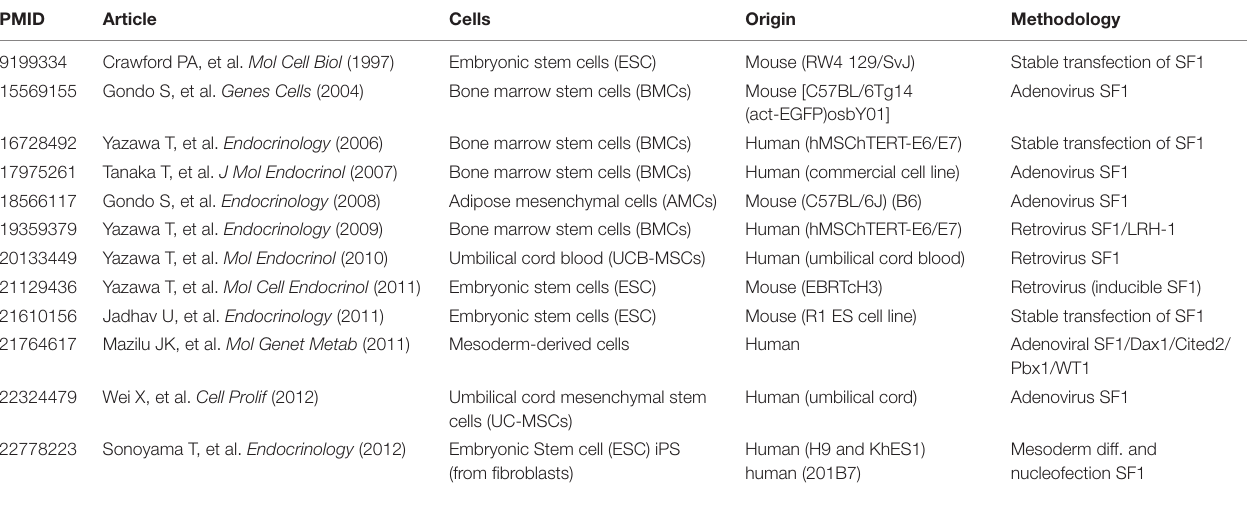
TABLe 1 | Details of published studies on adrenocortical or adrenogonwadal reprograming.